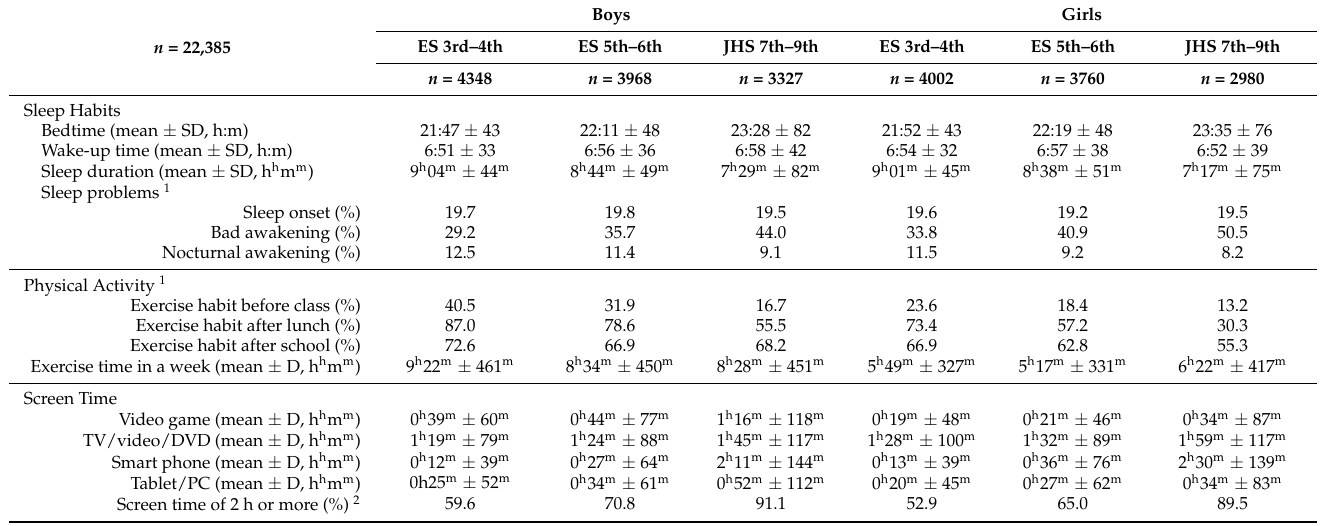
Table 1. Sleep habits, physical activity, and screen time of children by sex and grade